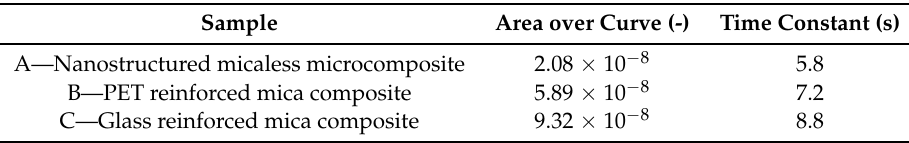
Table 3. Parameters determined from resorption current.